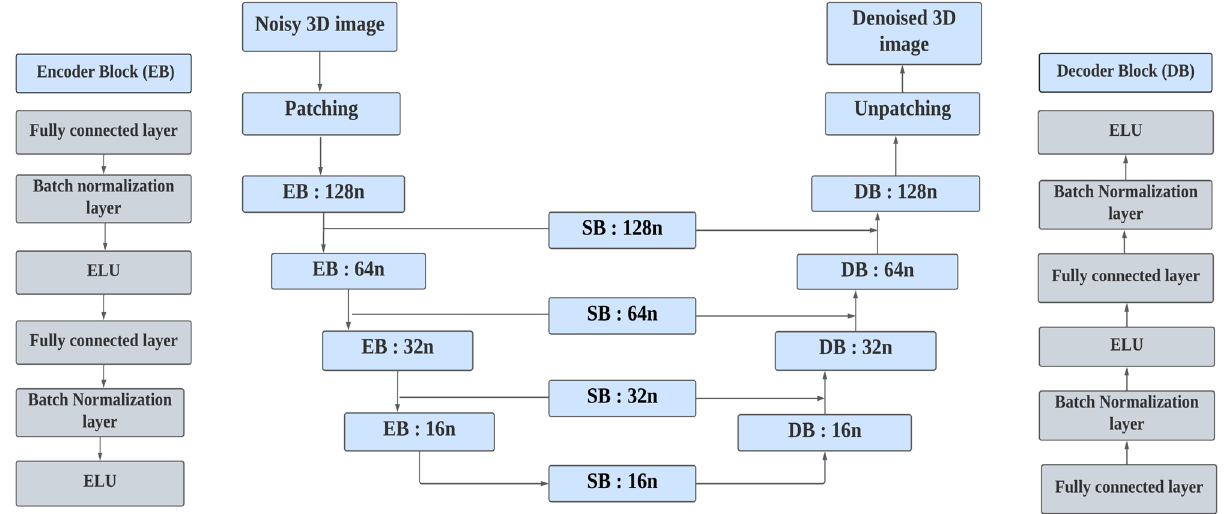
Figure 2. Architecture of the unsupervised denoising network; EB-encoder block, DB-decoder block, and SB-skip